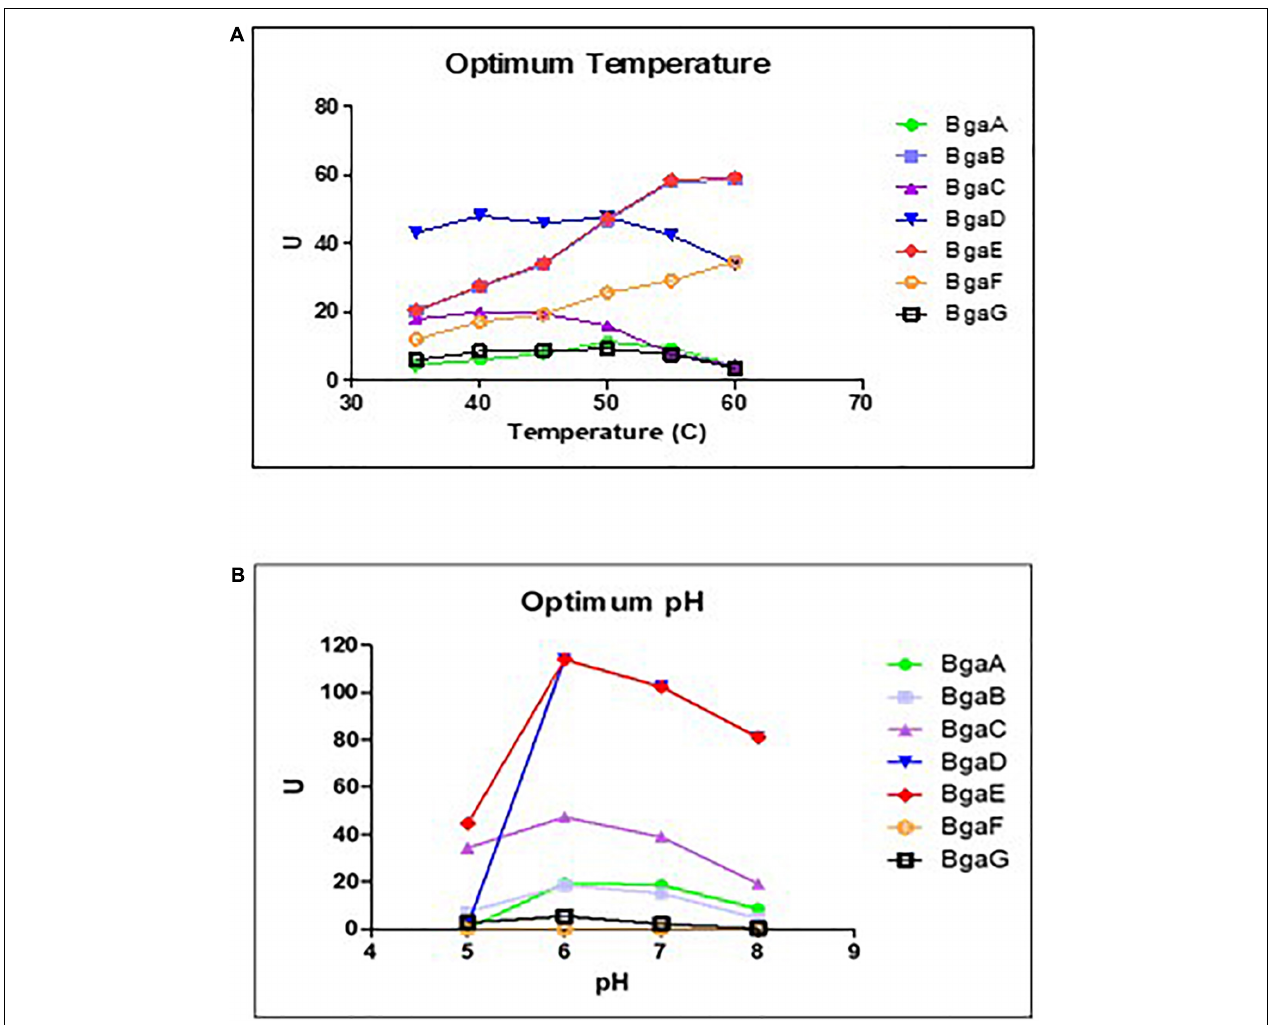
FIGURE 1 | Effects of pH and temperature on enzyme activity. Determination of optimum temperature (A) and the optimum of pH (B) on enzyme activity of the seven bifidobacterial β - galactosidases Data represent the rate extrapolated by plotting enzyme activity obtained from three independent experiments (mean). The experiments conducted to investigate the optimum temperature were performed at pH 6, while the experiments aimed to determined the optimum pH were performed at the best temperature obtained.